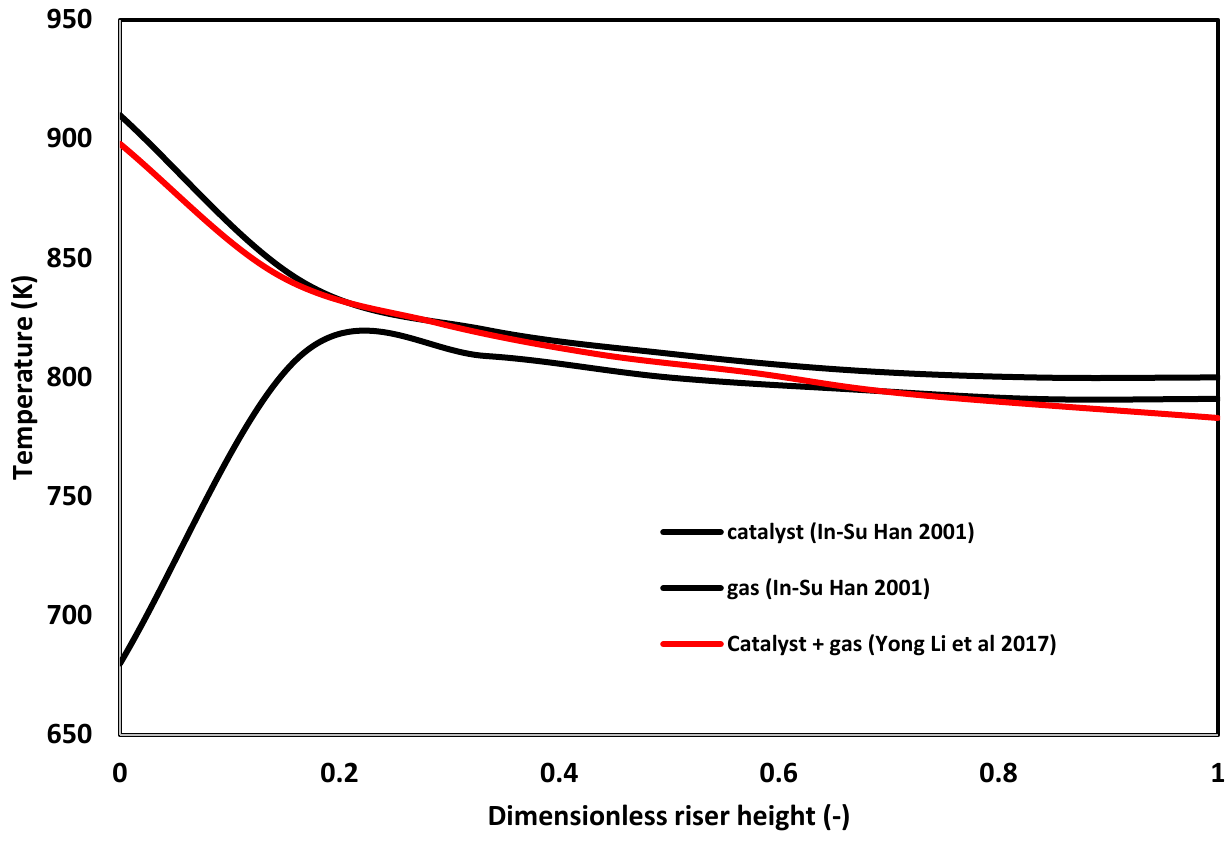
Figure 10. Comparison of predicted temperature profiles of models with gas – catalyst thermal equilibrium and with catalyst – gas interphase resistance.